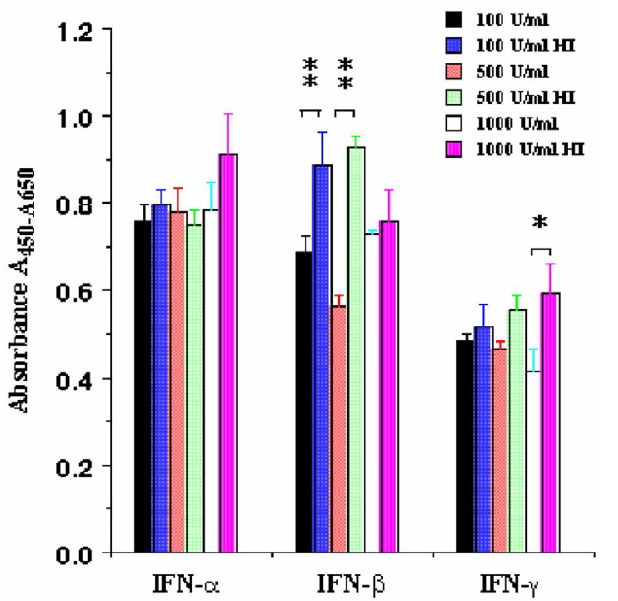
Figure 5 Effect of interferons on SMA abundance in rat HSCs. Sub-cul- tured HSCs were incubated with 500 U/ml of IFN- α , IFN- β and IFN- γ for 3, 6, or 9 days. Panel A exhibits the typical Western blot of SMA expression. Panel B represents densit- ometric data of Western blot analysis. Active form of IFNs was compared with heat-inactivated (HI) form of IFNs, which were arbitrarily set at 1. The data represent mean ± SEM from four